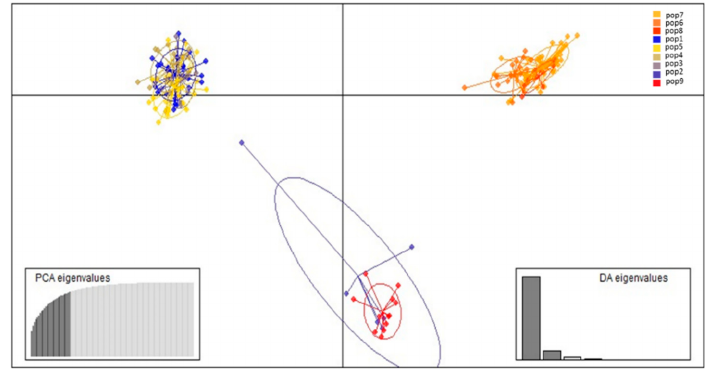
of A. marina. Samples are color coded according to their membership in the nine populations. Forests 2020 , 11 , x FOR PEER REVIEW